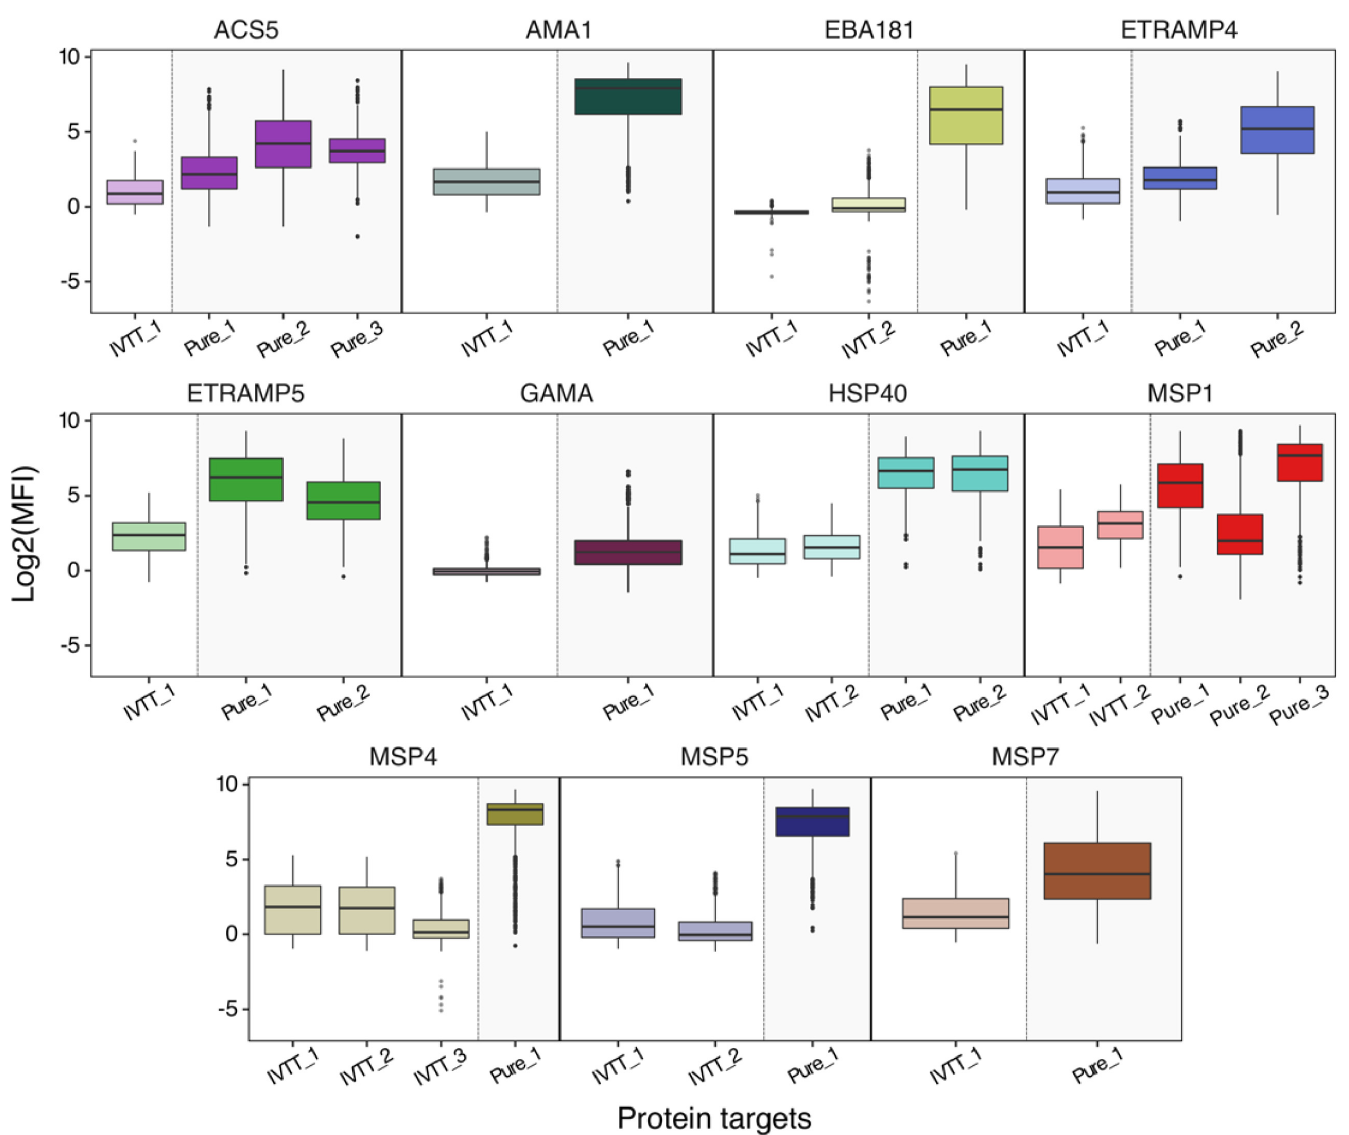
Fig 2. Magnitude and range of response to IVTT and purified proteins. All sample responses (n = 899) to all protein targets grouped by antigen, presented with median and interquartile range.